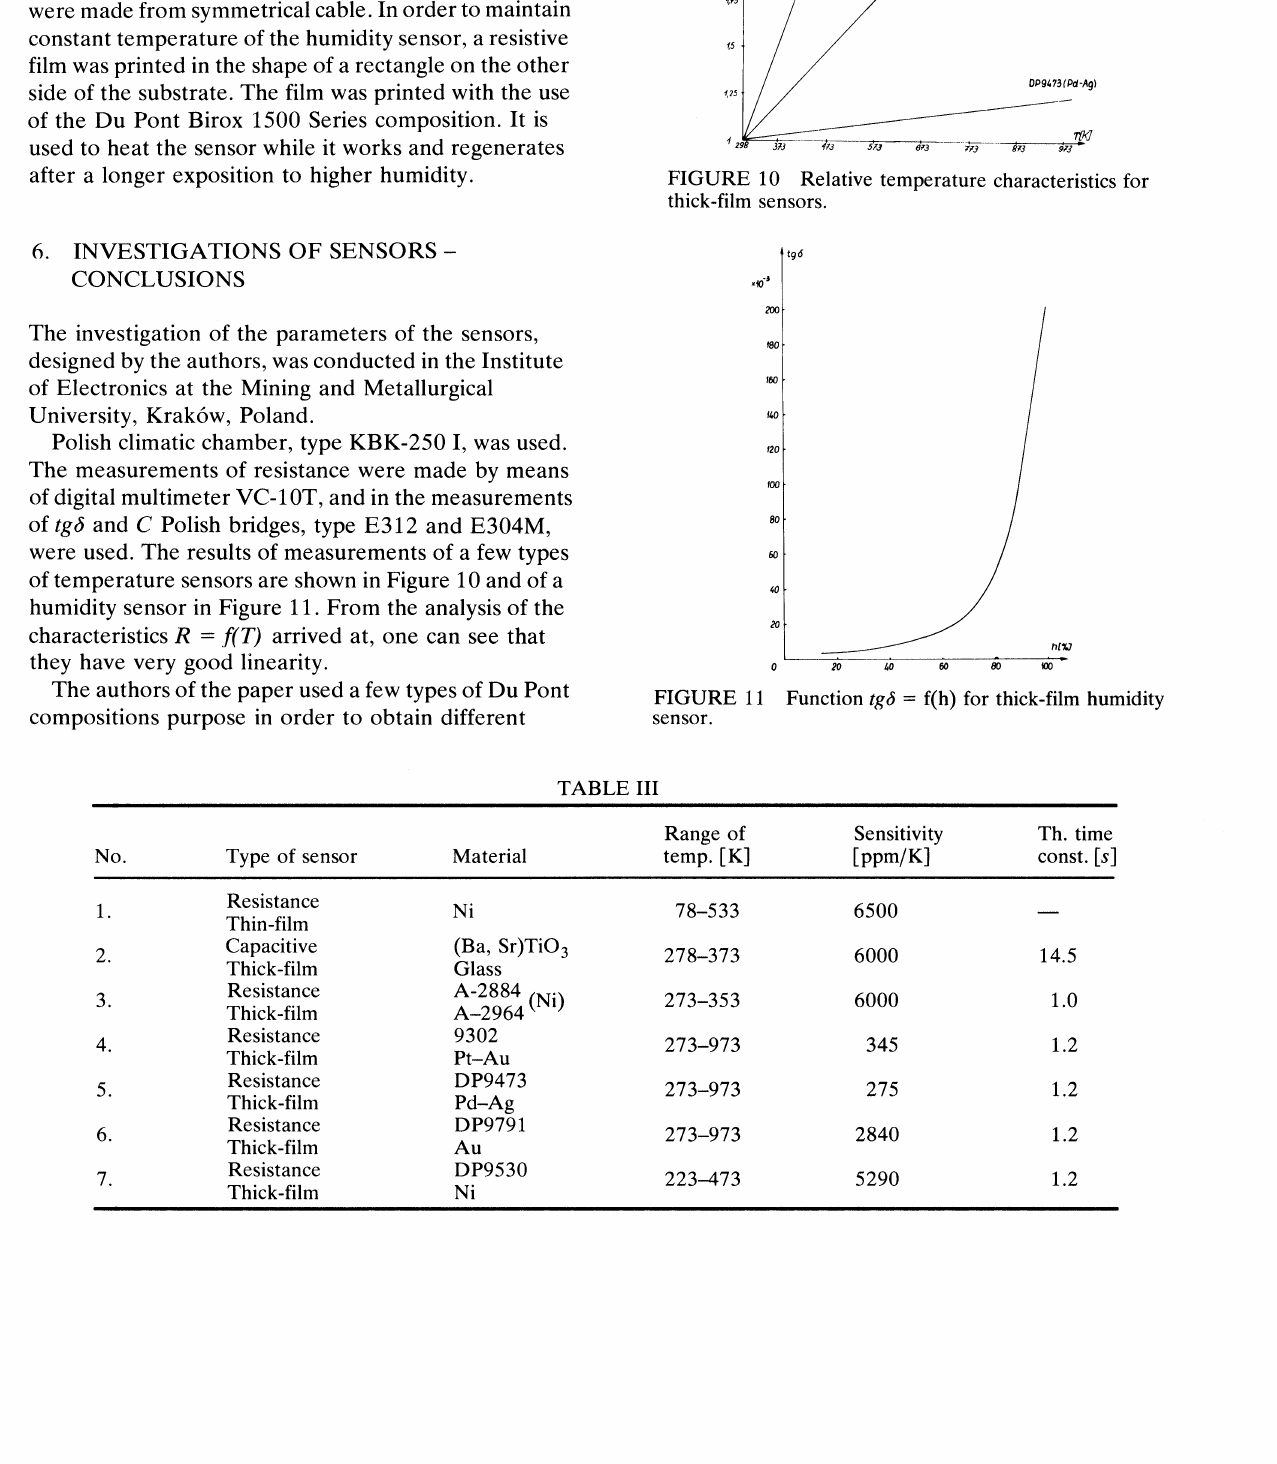
FIGURE 10 Relative temperature characteristics for thick-film sensors.